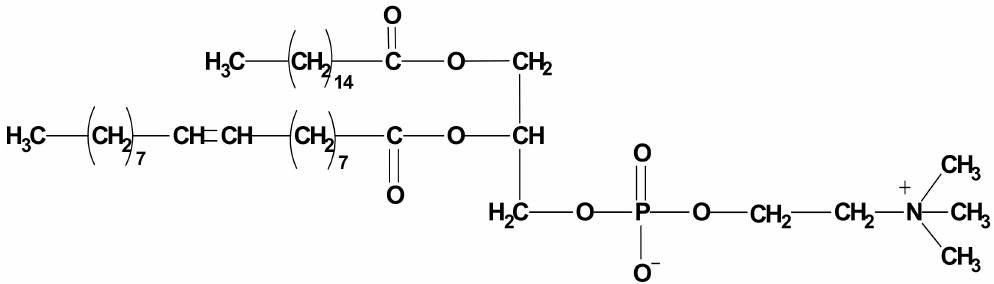
Figure 5. General structure of phosphatidylcholine. Adapted from